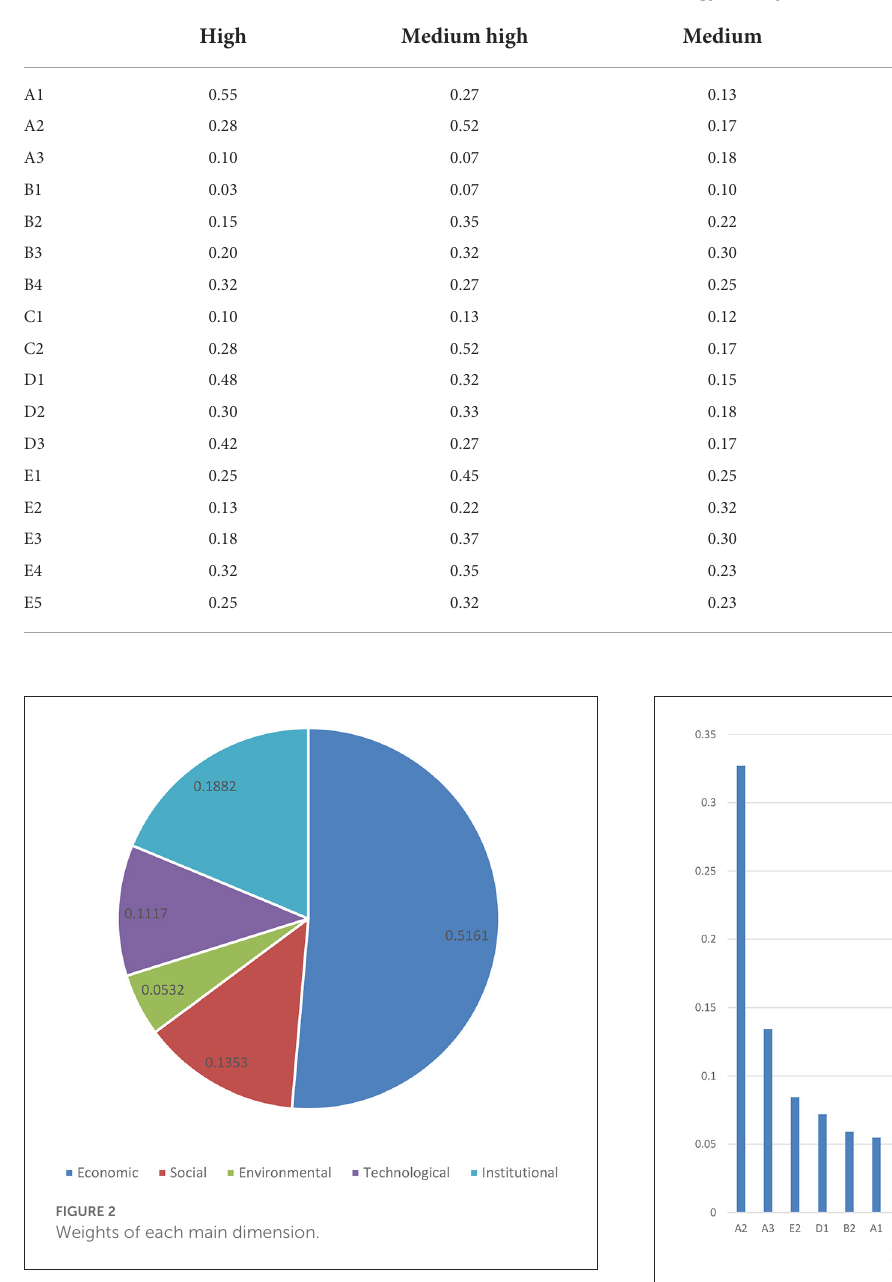
TABLE 7 Evaluation results based on 60 interviews with individual-level Solar-energy Poverty Alleviation Program (SEPAP) households.